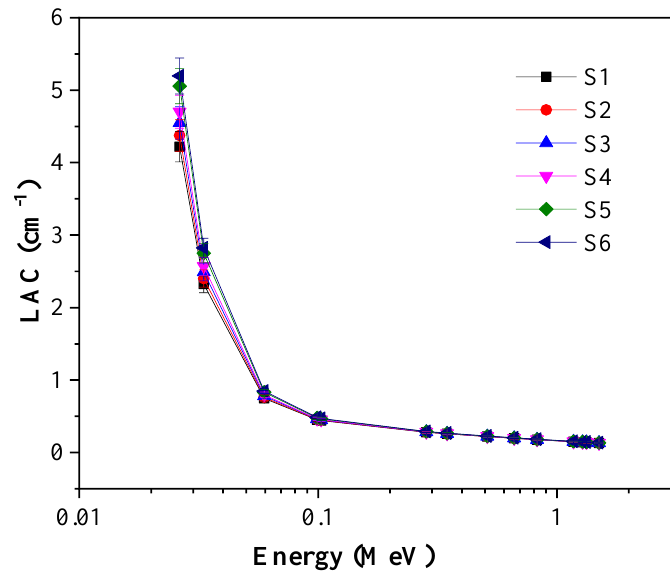
Figure 6. Change in LAC against incoming gamma-ray energy.